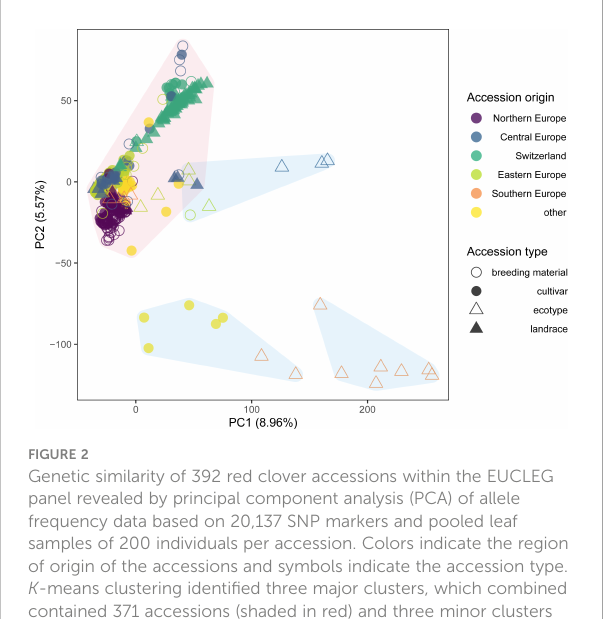
FIGURE 2 Genetic similarity of 392 red clover accessions within the EUCLEG panel revealed by principal component analysis (PCA) of allele frequency data based on 20,137 SNP markers and pooled leaf samples of 200 individuals per accession. Colors indicate the region of origin of the accessions and symbols indicate the accession type. K -means clustering identi fi ed three major clusters, which combined contained 371 accessions (shaded in red) and three minor clusters each comprising seven accessions (shaded in